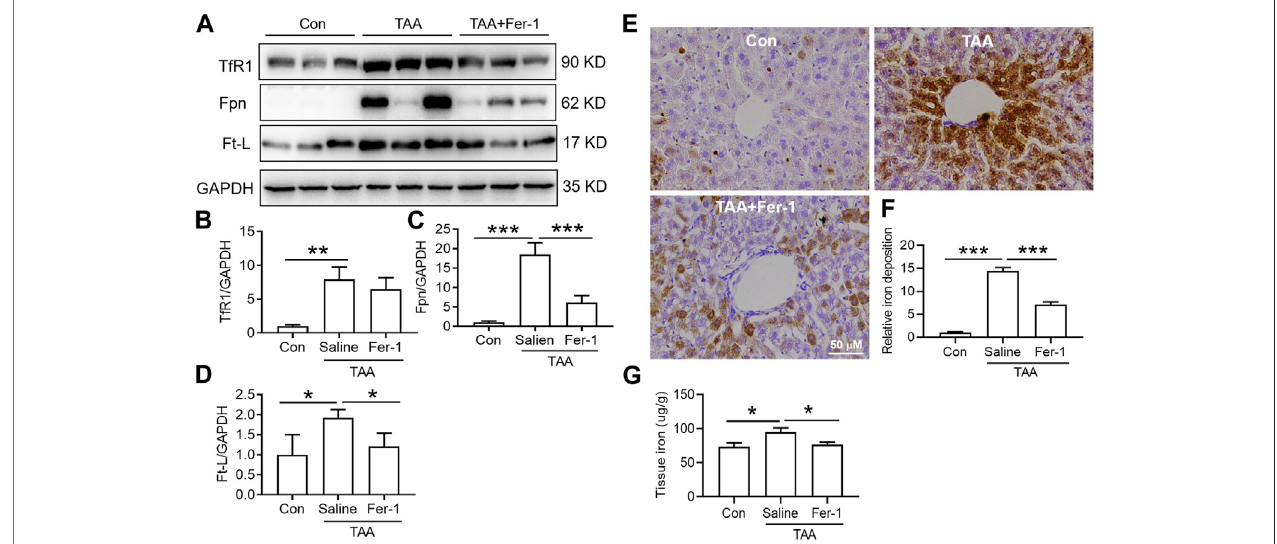
FIGURE 4 | Effects of Fer-1 on iron-related protein expression and iron content in TAA-induced ALI mice. (A) Western blotting analysis of TfR1, Fpn and Ft-L expression in the livers of mice after different treatments. (B – D) Relative protein expression of TfR1, Fpn and Ft-L in (A) (E) Fer-1 suppressed the increase in positive centrolobular iron deposition induced by TAA. (F) Semiquantitative iron levels in the mouse livers described in (E) (G) Iron content detection in the livers of mice with different treatments. All data are presented as the mean ± SEM ( n = 6-9 mice per group); * p < 0.05, ** p < 0.01, and *** p < 0.001 versus the indicated group.